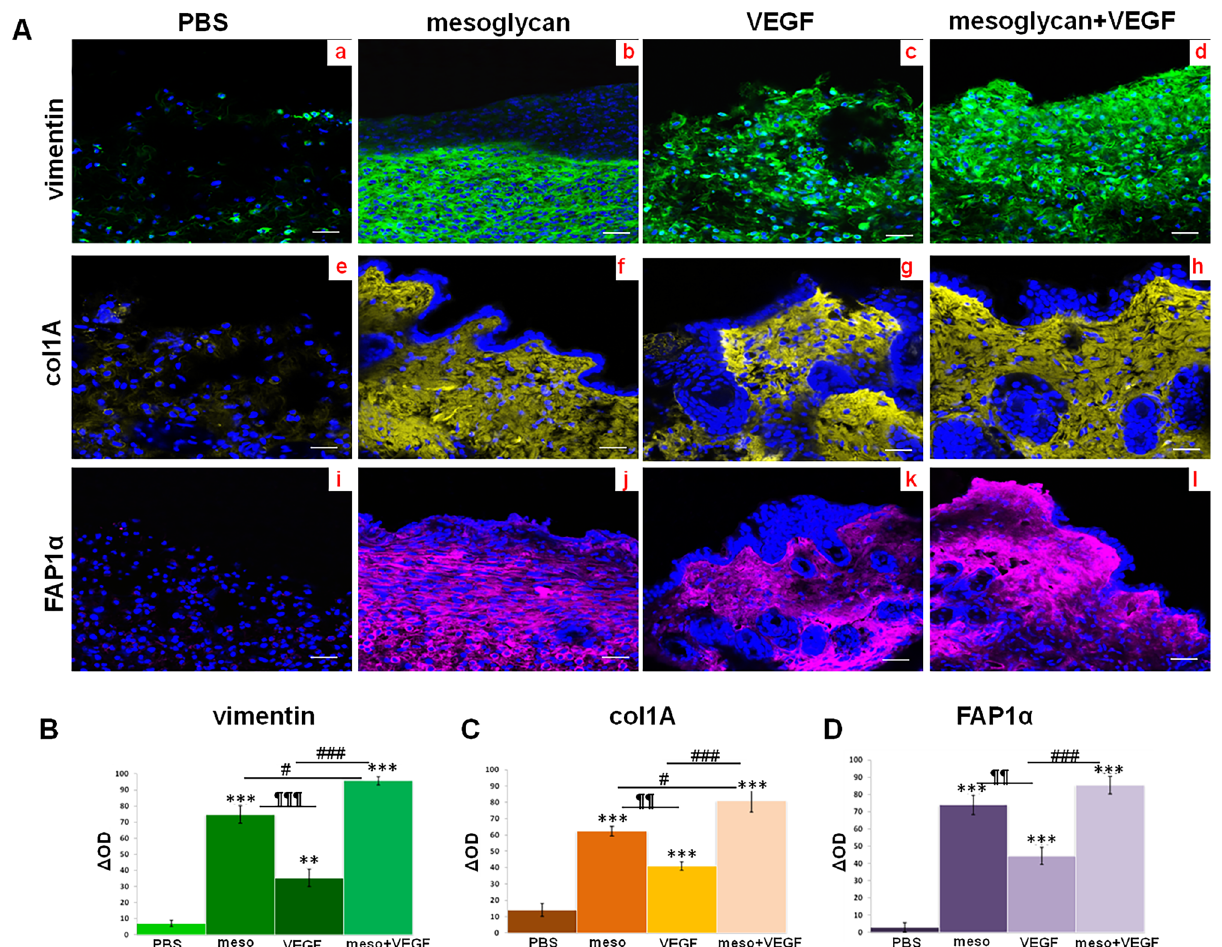
Figure 4. ( A ) Immunofluorescence analysis of mice sections vimentin (panels a–d); col1A (panels e–h); FAP1α (panels i–I). Densitometry analysis of fluorescence intensity of the same protein markers ( B ) for vimentin; ( C ) for col1A; ( D ) for FAP1α). The data represent a mean of n = 3 independent experiments ± SD based on one-way ANOVA and a two-tailed Student’s t -test as appropriated, *p < 0.05, **p < 0.01, ***p < 0.001 versus untreated control; # p < 0.05, ## p < 0.01, ### p < 0.001 for combination versus mesoglycan or VEGF treated cells; ¶¶ p <